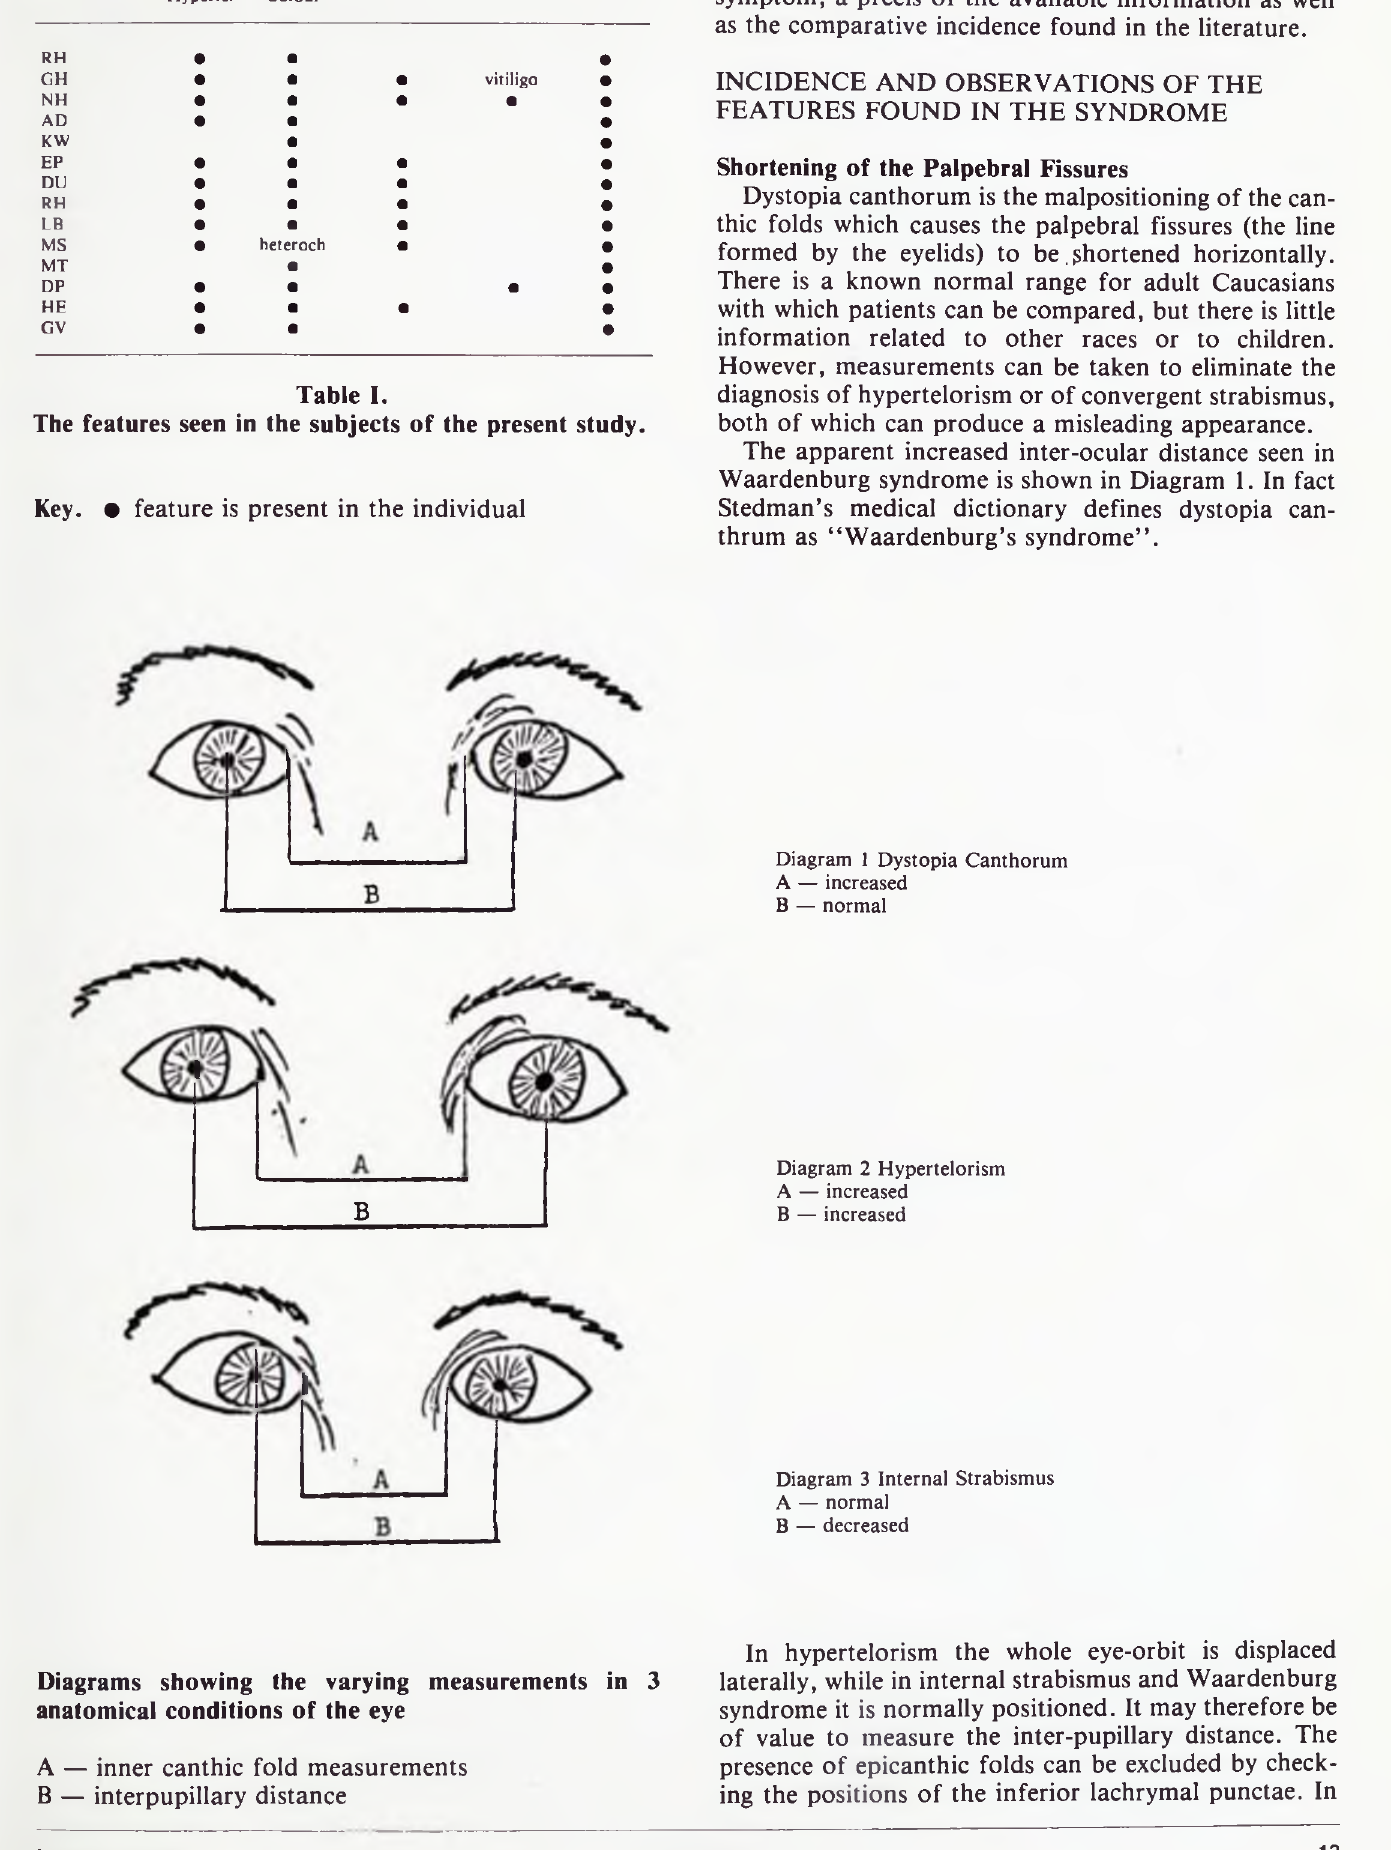
Diagrams showing the varying measurements in 3 anatomical conditions of the